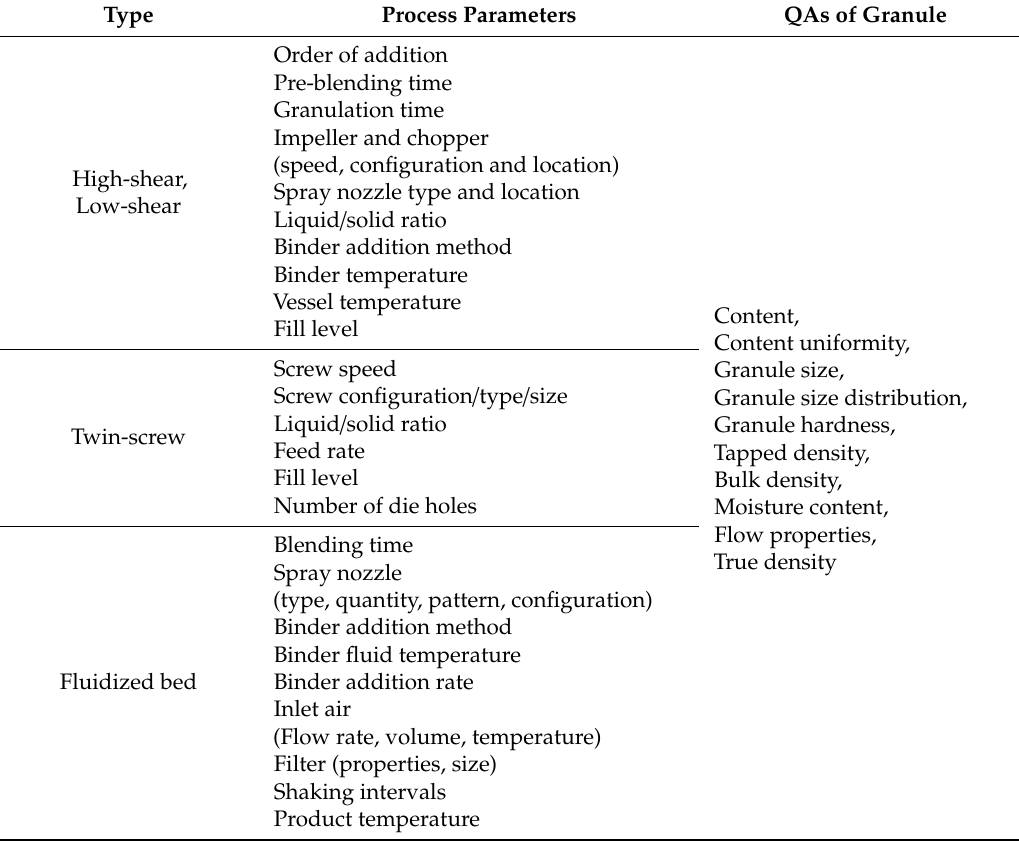
Table 2. Process parameters and quality attributes (QAs) of granule by granulator